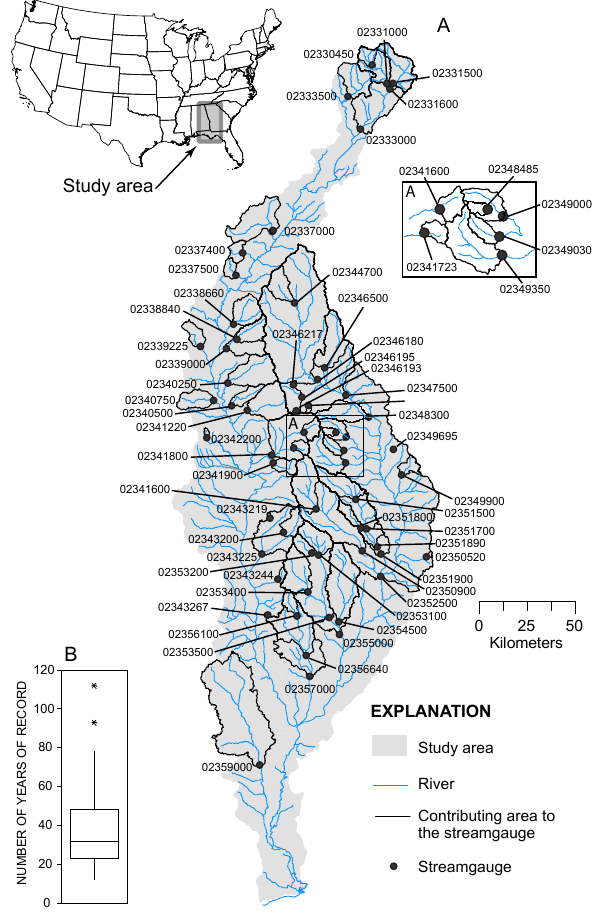
Fig. 1. Map (A) shows the locations of and contributing catchment areas to the 61 study streamgauges located in the southeast United States. The range of record lengths (B) across the study stream- gauges is also shown.